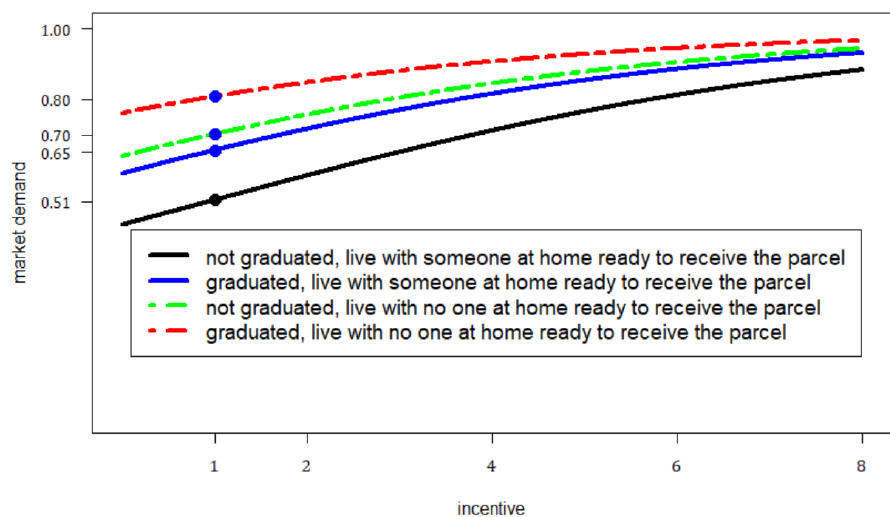
Figure 2. Scenario I–base scenario with h24 accessibility.